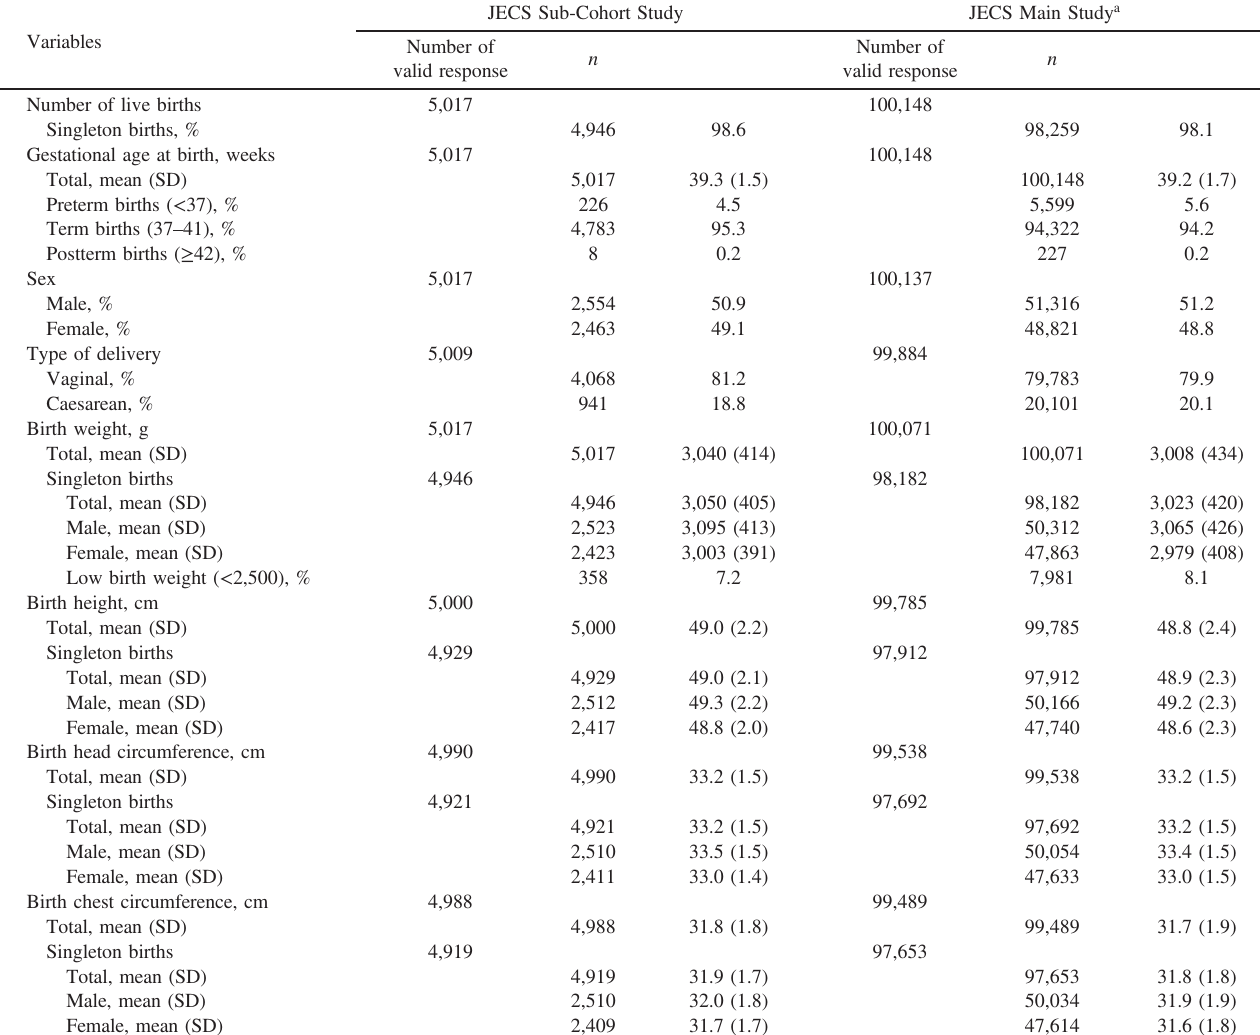
JECS Sub-Cohort